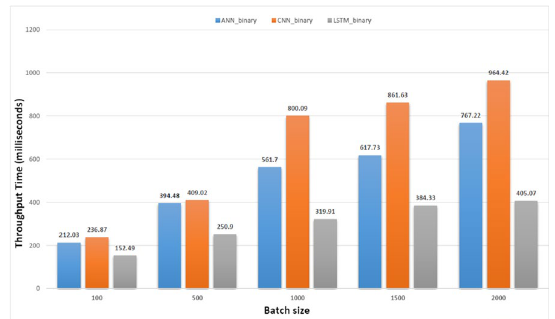
Fig. 19 Throughput of binary classification based on batch size